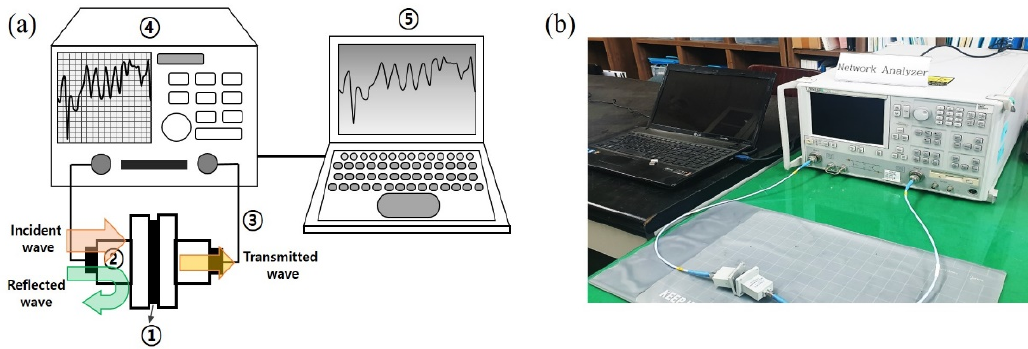
Figure 2. ( a ) Schematic of the vector network analyzer (VNA): ① sample, ② waveguide test holders, ③ coaxial cables, ④ VNA, and ⑤ computer; ( b ) optical photograph of the experimental setup for EMI shielding measurements.